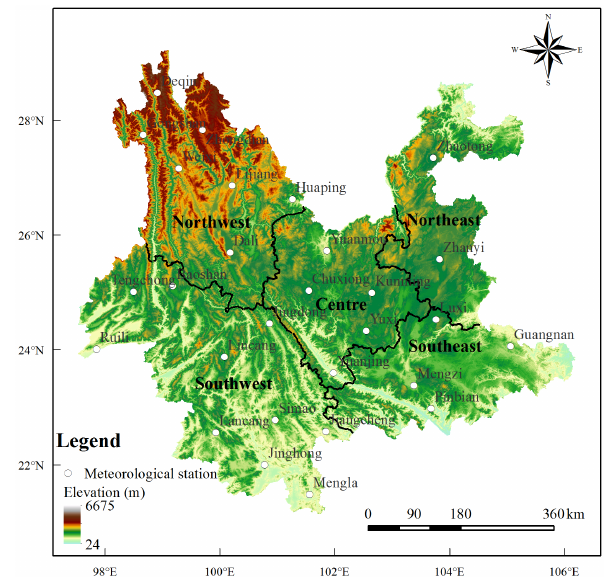
Figure 1. Spatial distribution of 28 meteorological stations in Yun- nan Province,